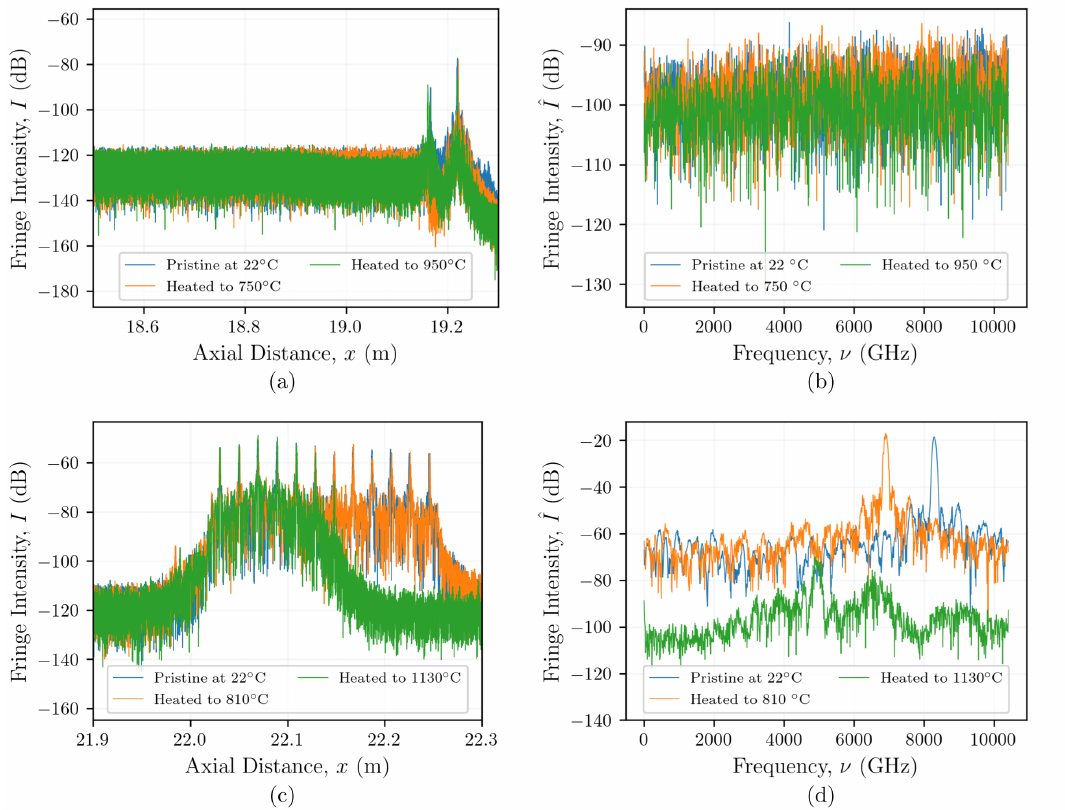
Figure 2. Examples of OBR measurements made during thermal testing using fibers with and without FBGs: ( a ) x domain data from a fiber without FBGs at room temperature and after heating to 750 and 950 ◦ C, ( b ) ν domain data from A between 19.050 m and 19.060 m, ( c ) x domain data from a fiber with inscribed femtosecond Type-II FBGs at room temperature and after heating to 810 and 1130 ◦ C, and ( d ) ν domain data from ( c ) between 22.187 and 22.193